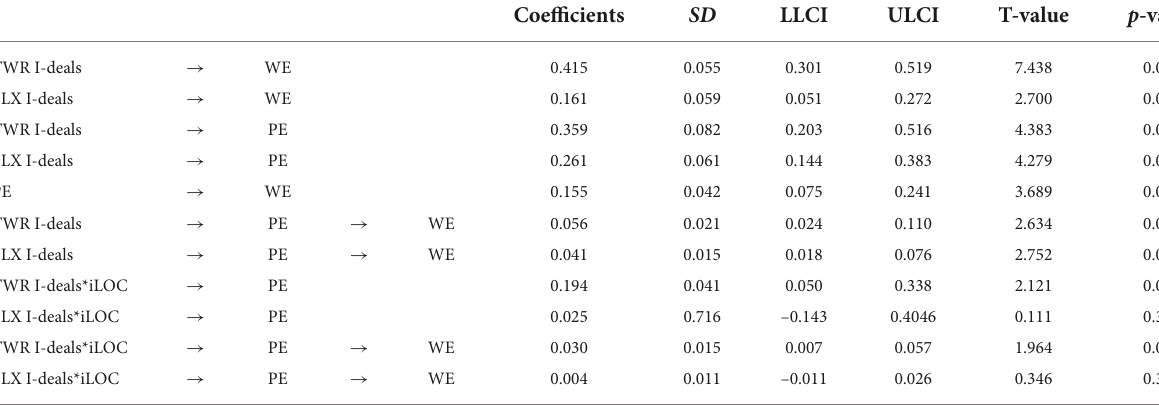
TABLE 3 Hypotheses